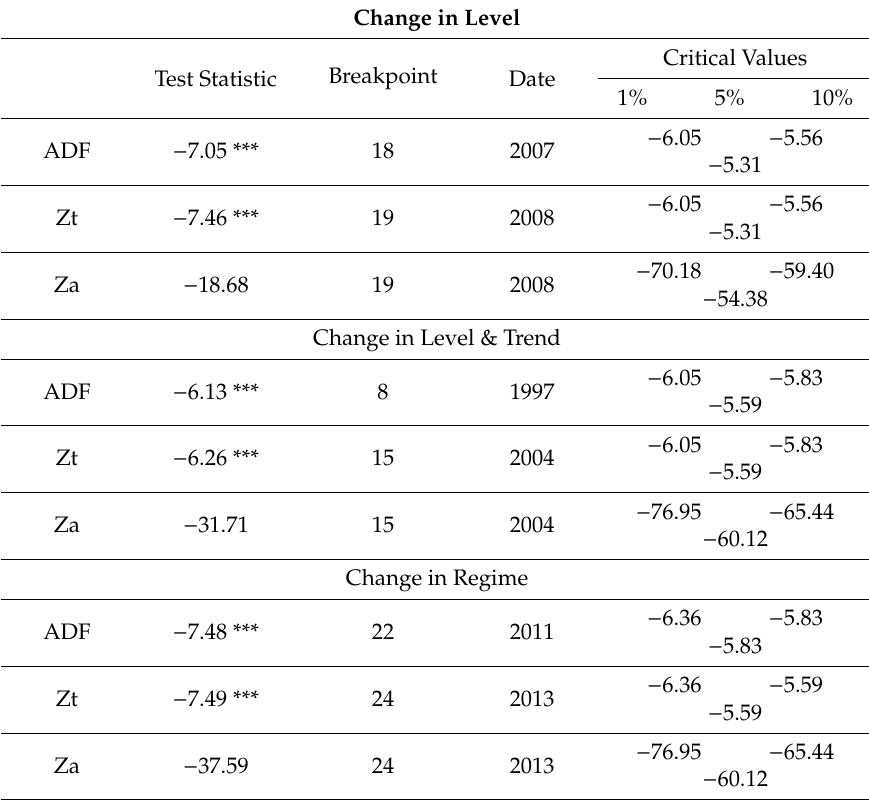
Table 5. Gregory–Hansen test for co-integration with regime shifts (GDP): change in level. Change in